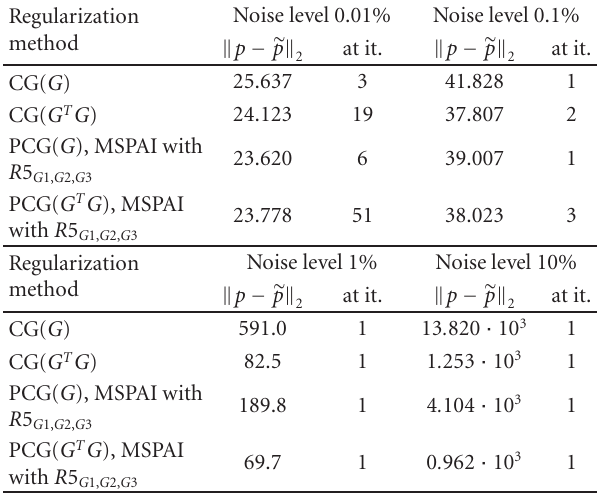
at given iteration 2 for (cid:0)(cid:2)(cid:3)(cid:4)(cid:5)(cid:6)(cid:7)(cid:8)(cid:9)(cid:10)(cid:9)(cid:6)(cid:11)